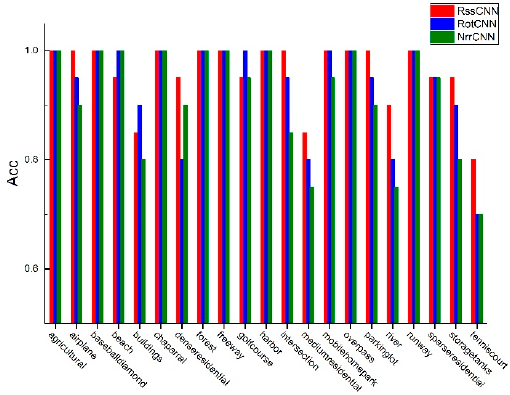
Figure 15. The class accuracy of the RssCNN, RotCNN and NrrCNN on the UCM.